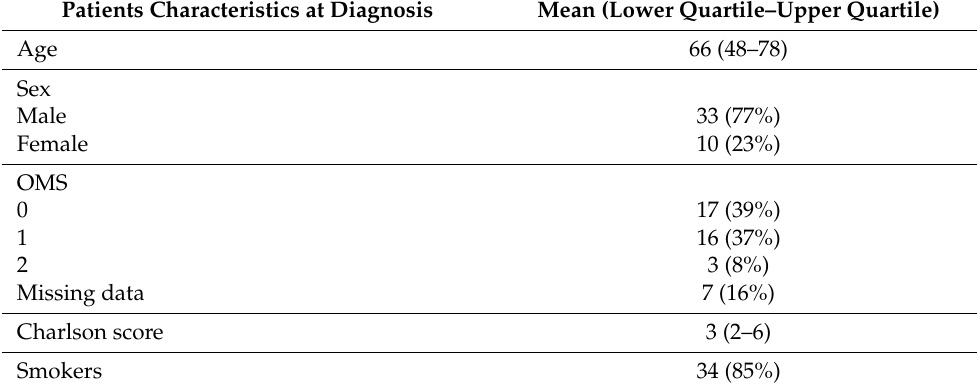
Table 1. Patients characteristics.